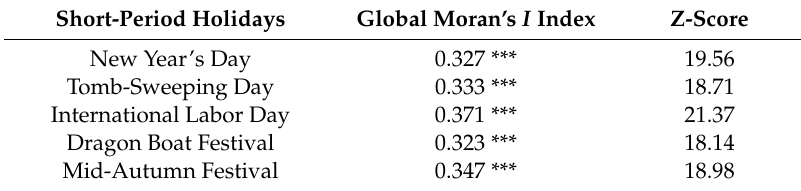
Table 3. Global Moran’s I index and its statistical significance for travel rates in prefecture-level cities.